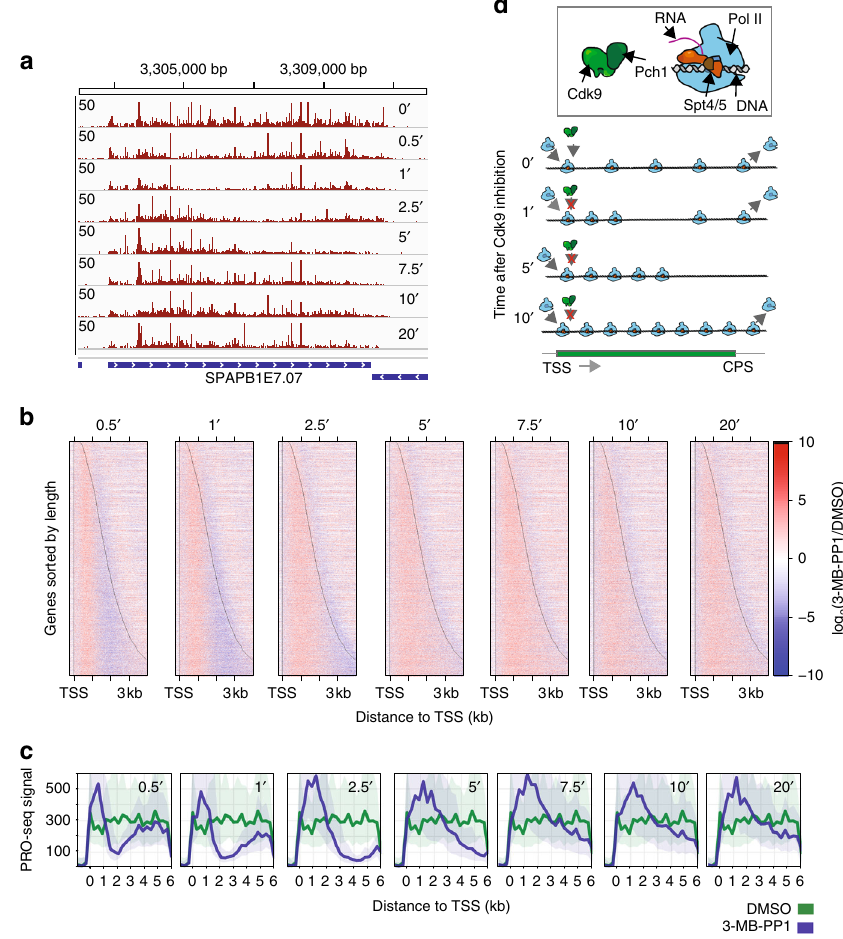
Fig. 3 A checkpoint during early elongation impacts Pol II rates. a Browser track image displaying the normalized PRO-seq read count signal at the SPBAPB1E7.07 locus for cdk9 as cells treated with 10 μ M 3-MB-PP1 for an increasing duration, from top to bottom. b Heat maps of log normalized PRO-seq signal within 10 bp windows from − 250 bp to +4000bp around the TSS for all fi ltered genes ( n = 3383) ordered by increasing gene length from top to bottom. Panels show PRO-seq data from each time point of drug treatment (relative to the 0-min sample), with increasing duration from left to right. c Composite PRO-seq signal for all fi ltered genes at least 6 kb in length ( n = 42) before and after treatment. Panels from left to right show pro fi les after increasing duration of treatment compared with DMSO-treated cells. Data used in a – c re fl ect the results of combined data from two biological replicates for each treatment. d Illustration of two populations of transcribing Pol II, which have rates differentially affected by Cdk9